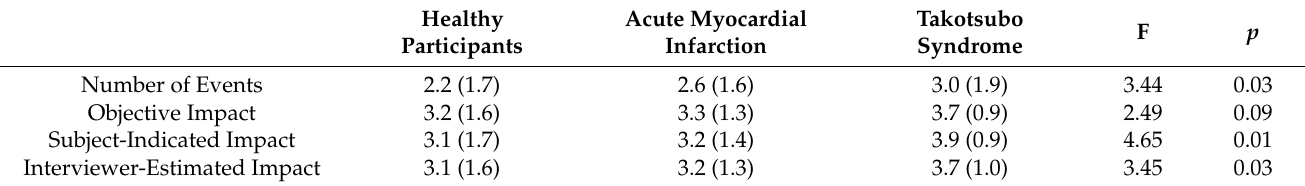
Table 4. Statistical results of the trigger indices reported by the groups.